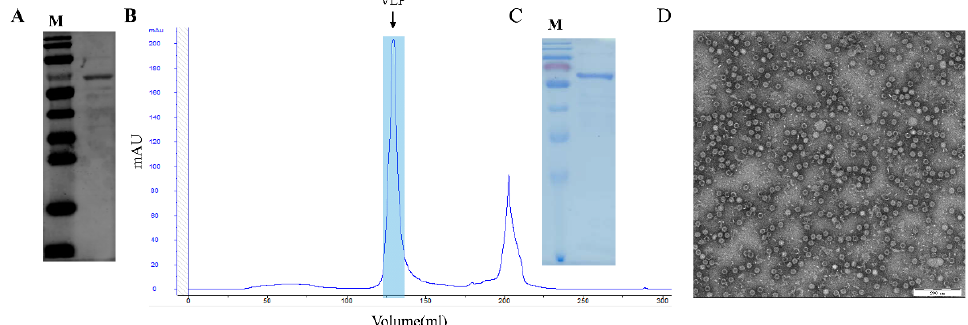
Figure 2. Analysis and purification of PPV VP2 protein and PPV-VLPs after initial HP. ( A ) Western blot analysis of PPV VP2 protein probed with specific positive serum. ( B ) Heparin-affinity profile of self-assembled PPV-VLPs. The peak represents properly-assembled PPV-VLPs. ( C ) Coomassie staining of the PPV VP2 protein. ( D ) The TEM image of the PPV-VLPs.